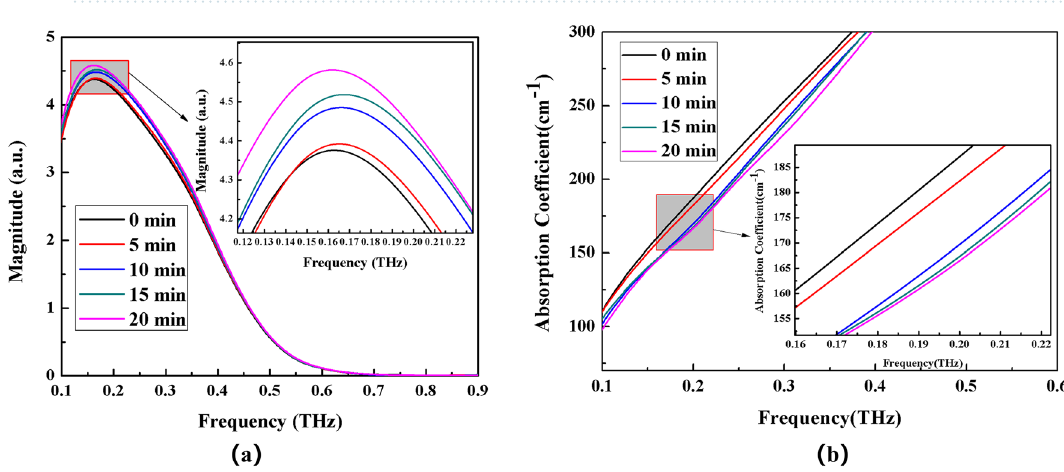
Figure 8. Frequency domain spectrum ( a ) and absorption coefficient spectrum ( b ) of (NH 4 ) 2 CO 3 solution with different time electric field applied